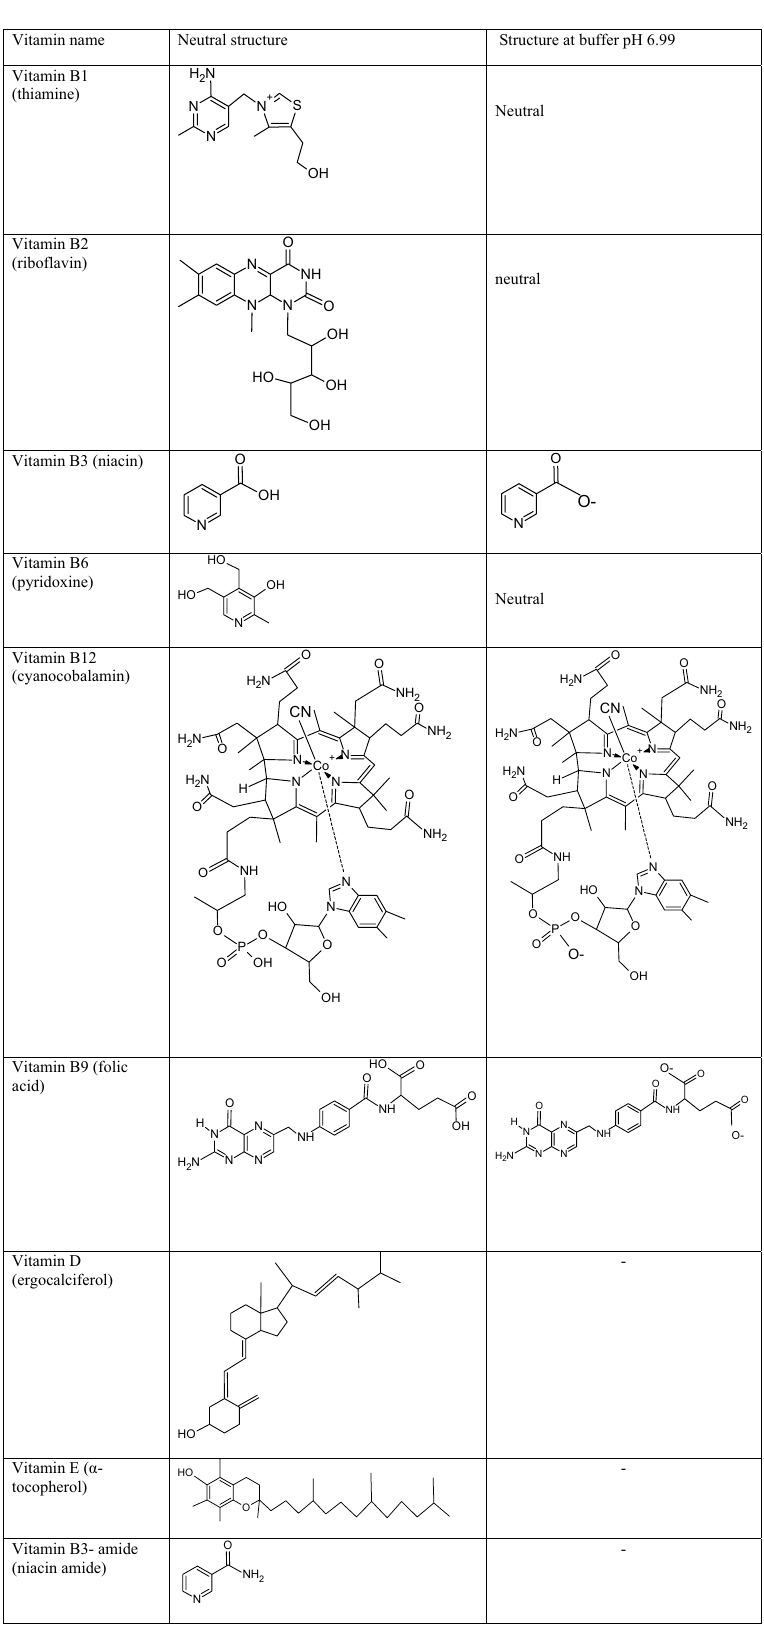
Table 4. Chemical structures of investigated compounds in neutral and ionic forms at buffer pH